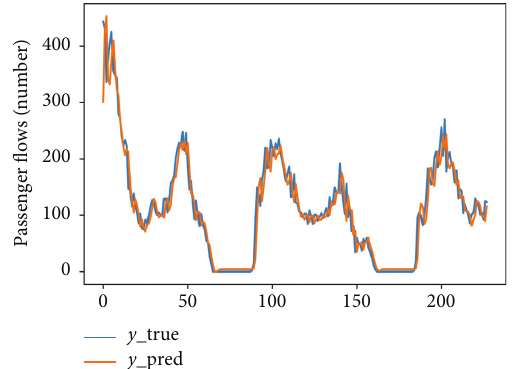
Figure 16: Regression integration prediction results when the time step is 1h.